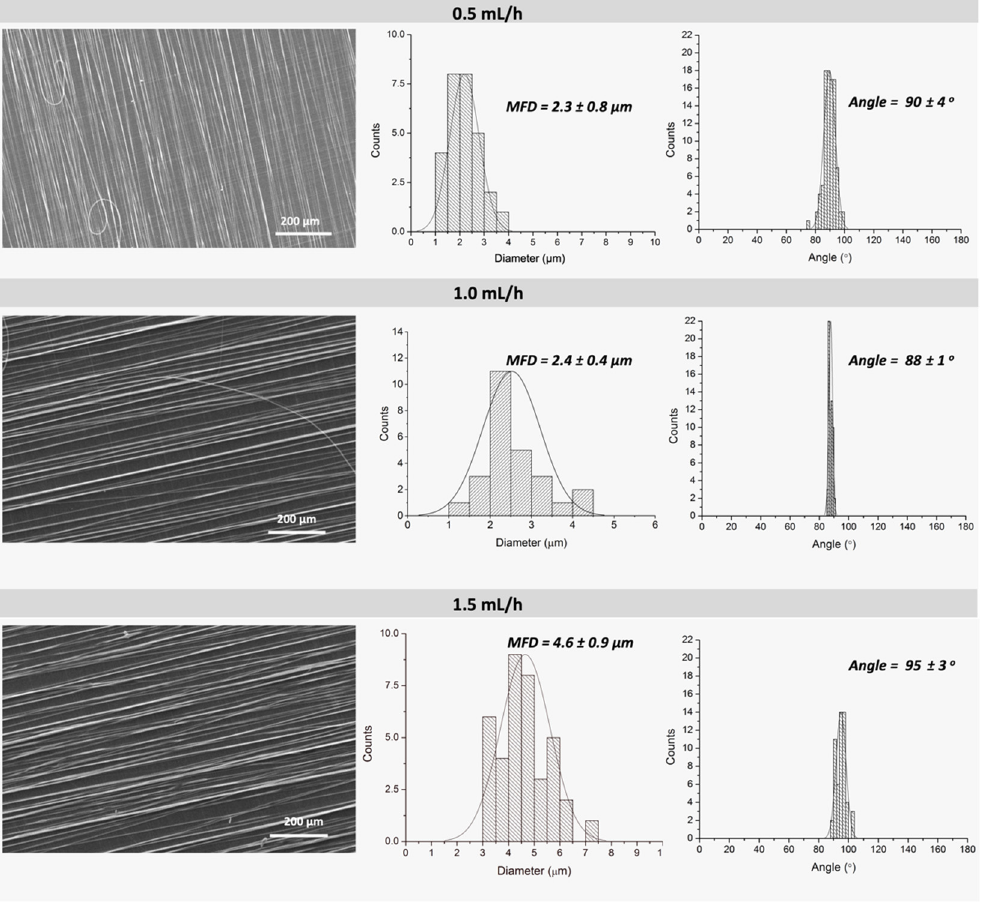
Figure 5. SEM micrographs (row 1) corresponding to PLA fibers (20 wt.% PLA, 90:10 CHCl 3 :DMF) obtained using 3 different feeding rates: 0.5, 1.0 and 1.5 mL/h and their respective histograms corresponding to mean fiber diameter and orientation. (Electrospinning fixed parameters: 16 kV, needle-to-collector distance 12 cm and rotor velocity 1300 rpm).